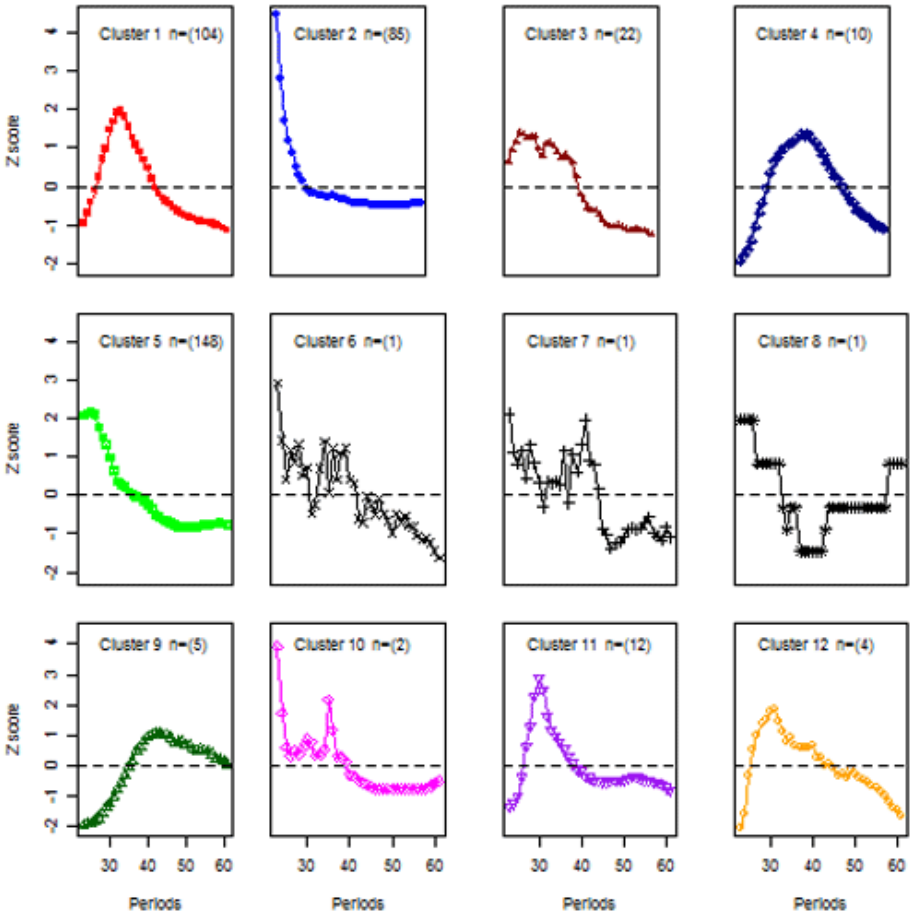
Figure 8. Centroids of the 12 Streamflow Regime Type clusters.